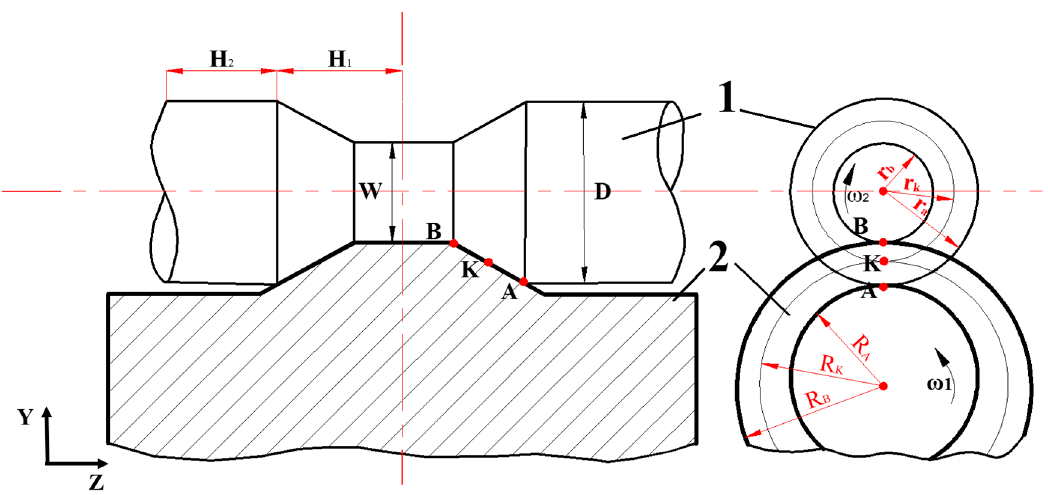
Figure 1. The front view and side view of the typical cross-wedge rolling (CWR) process. 1 is the rolling piece, 2 is the roller.